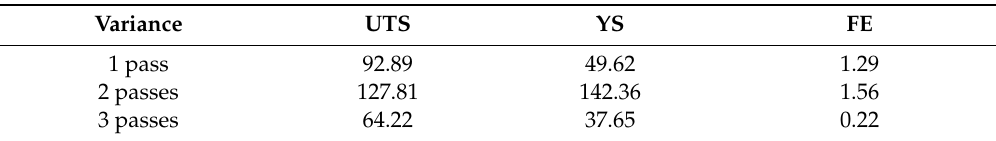
Figure 7. Mechanical properties of the alloys under different MDFed passes. Table 1. The scatter of the yield strength (YS), ultimate tensile strength (UTS) and failure elongation (FE) under different MDFed passes.